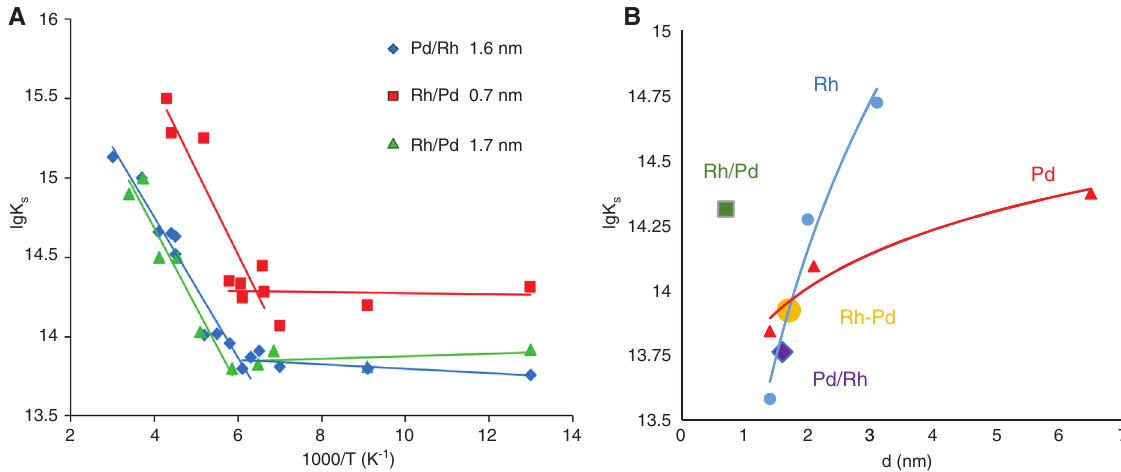
Figure 12 (A) Comparison of the catalytic properties of BMNPs. (B) Comparison of the catalytic properties of the investigated NPs at 77